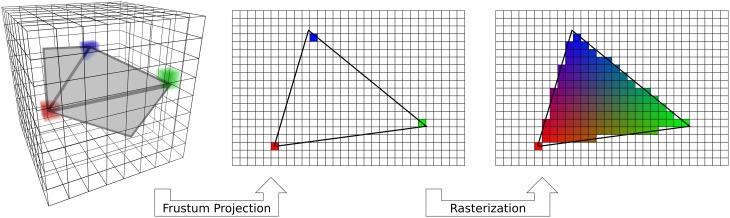
Standard vertex-based mapping. Standard OpenGL rendering implements an algorithm that can be used for vertex-based mapping. First, a fragment of the surface (gray) embedded in the voxel data (3D grid) is used to sample the data. Sampling occurs at only the vertices of the triangle (red, green, blue cubes). The surface triangle is projected to the screen on a regular 2D grid through a standard frustum projection (Woo et al., 1999). Only the data sampled by the vertices are carried over to the screen. Finally, the automatic graphics pipeline rasterizes the triangle by interpolating the colors across a barycentric coordinate space. Vertex-based mapping is generic, but does not adequately sample volumetric data.